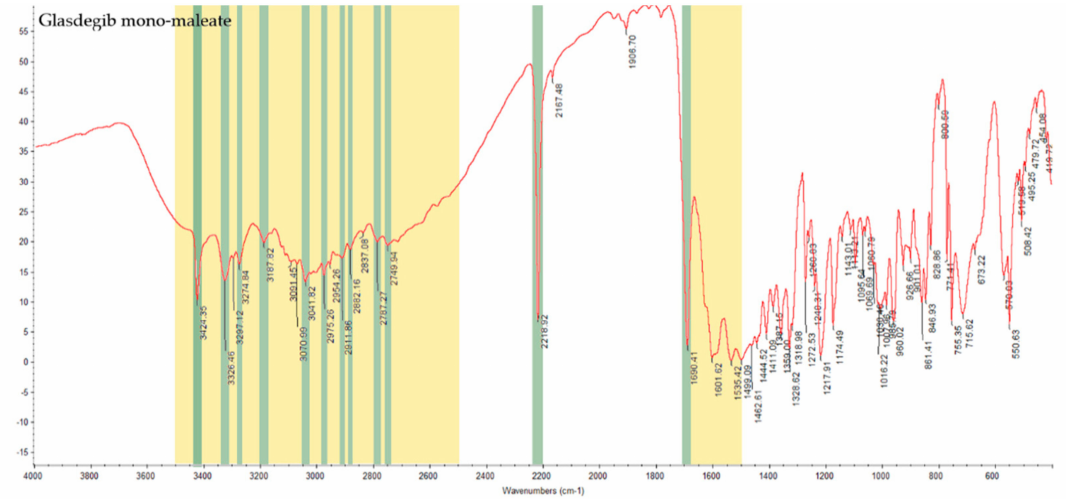
Figure 3. IR spectrum of glasdegib monomaleate with highlighted diagnostic regions and